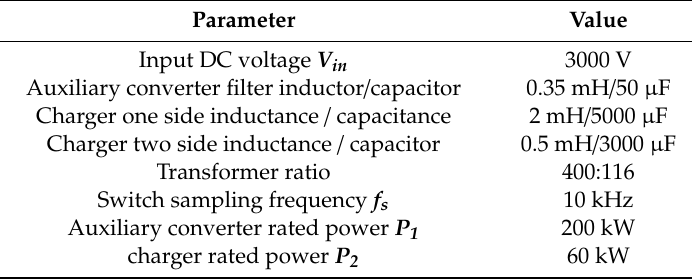
Figure 13. Power supply system simulation model. Table 3. Power supply system simulation parameters.